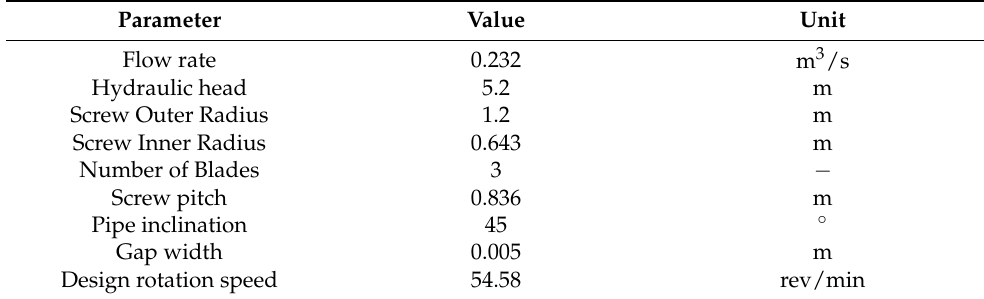
Table 1. Basic design parameters of the